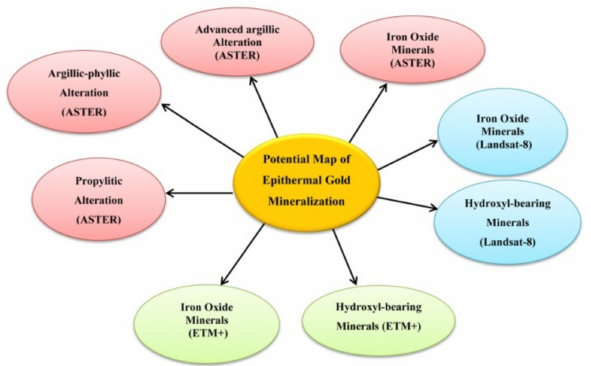
Figure 12. The DAG diagram used in this study for the fusing the thematic layers produced by image processing